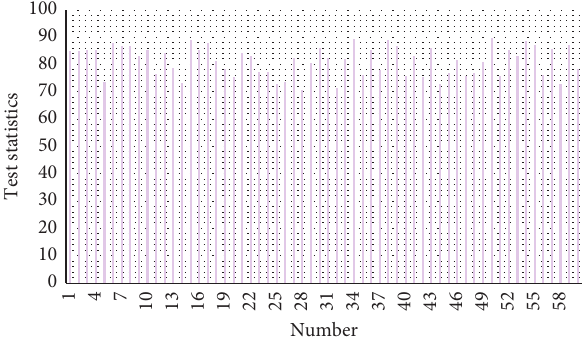
Figure 10: Statistical diagram of the music teaching effect of the multimedia-assisted music teaching system based on AI